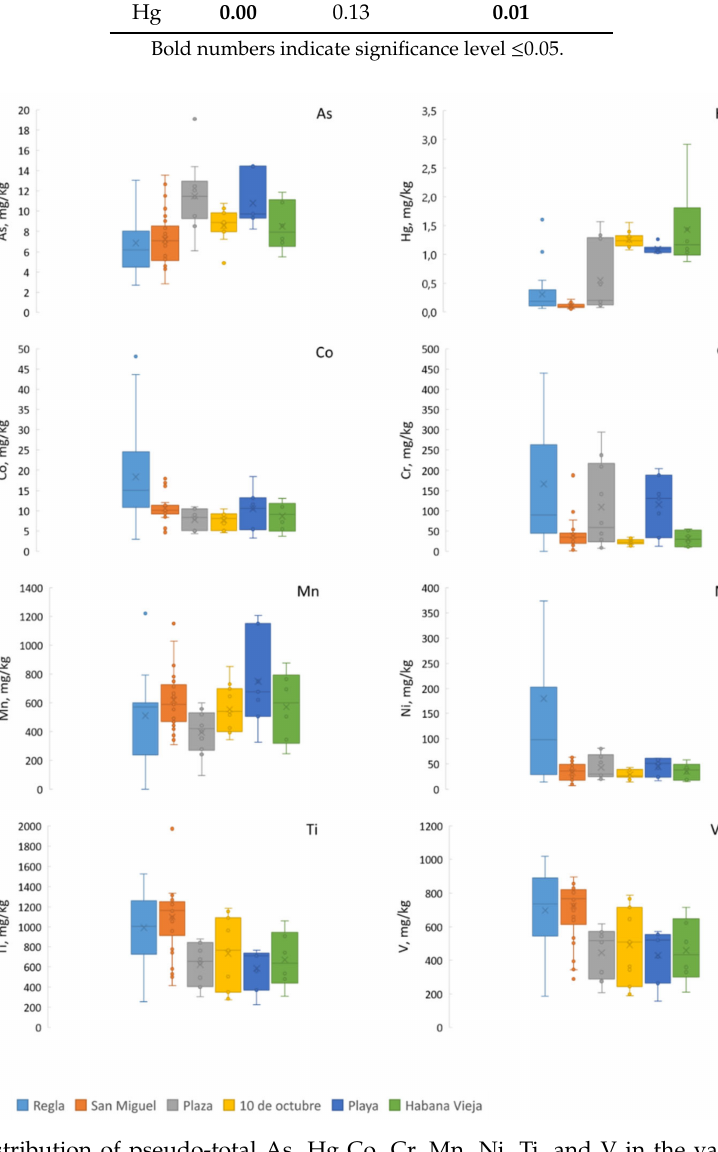
Figure 2. Distribution of pseudo-total As, Hg Co, Cr, Mn, Ni, Ti, and V in the various districts. The limits of the boxes are percentiles 25 and 75. The horizontal lines inside the boxes are the medians. The whiskers indicate the 0th and 100th percentiles, excluding